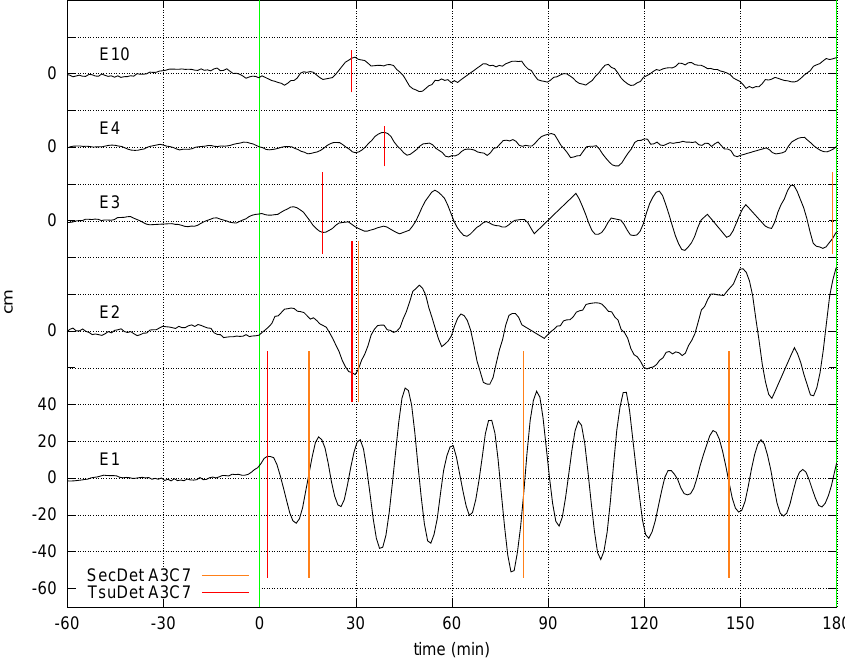
Fig. 11. TEDA detections shown on the detided records of the E1, E2, E3, E4 and E10 tsunamis, with the optimal configuration A3C7. Tsunami arrival time is at time t = 0. TEDA detection time (vertical lines) are shown both for TEDA tsunami detection and for TEDA secure detection. Method A3C7 corresponds to t IS = 12min, t G = 16min, t GTide = 17min, t BS = t Tide = 60min, and CF threshold equalling